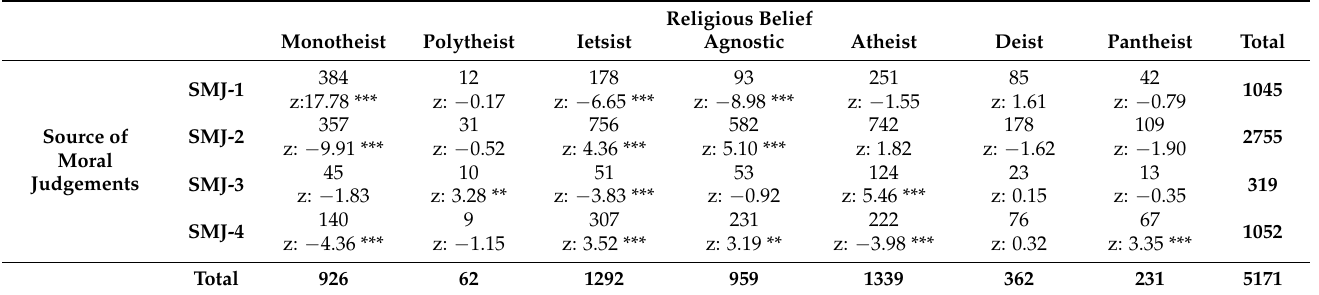
Table 6. Relationship between the religious belief and source of moral judgements (SMJ).